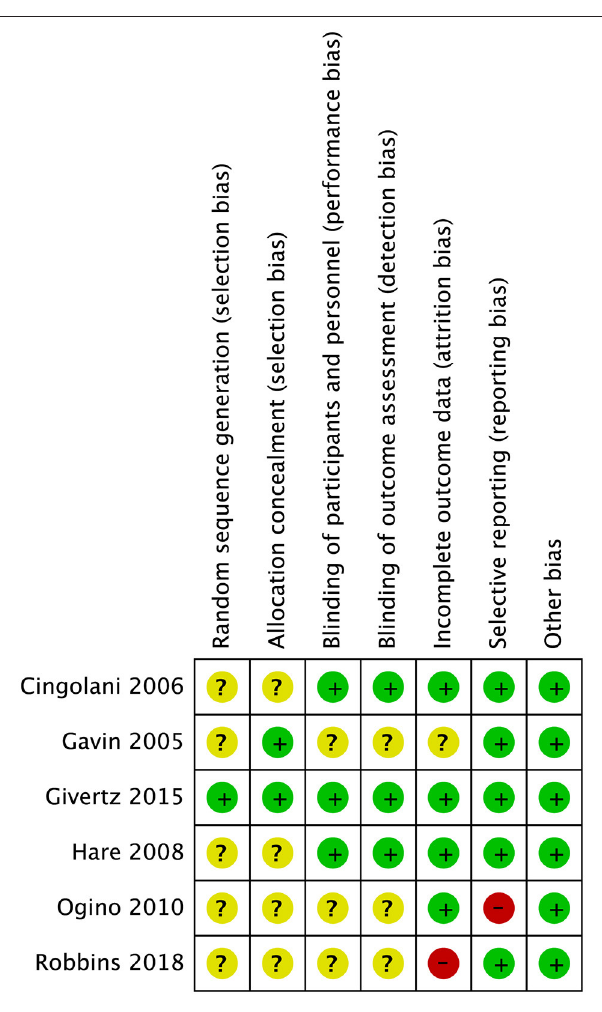
FIGURE 2 | Risk of bias